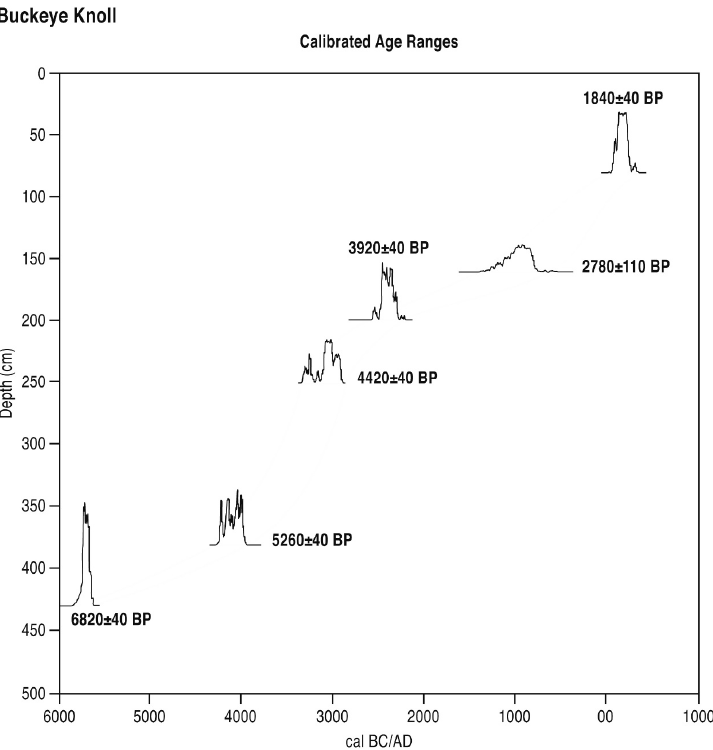
Figure 2. Age–depth graph of probability distributions of individual AMS and standard radiocarbon dates at Buckeye Knoll (BK) pollen site. Linear age estimates for dating of sediments used median calibrated ages.